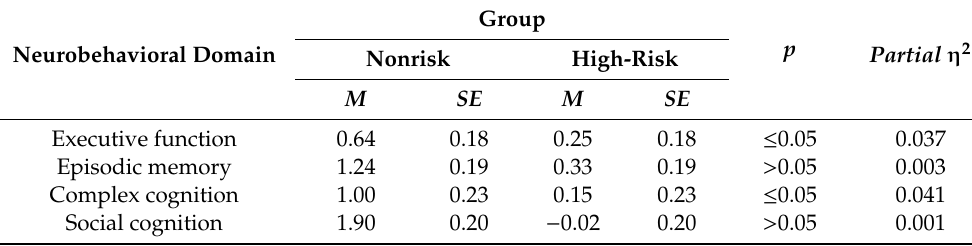
Table 2. Accuracy neurocognitive performance scores by